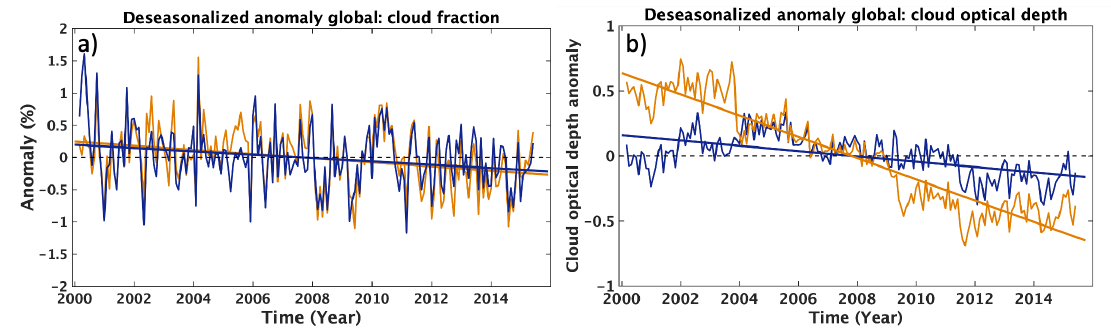
Figure 2. Anomaly in global monthly mean cloud fraction ( a ) and cloud optical depth ( b ). Oranges lines are from the CERES Edition 2 cloud product and navy lines are from CERES Edition 4 cloud